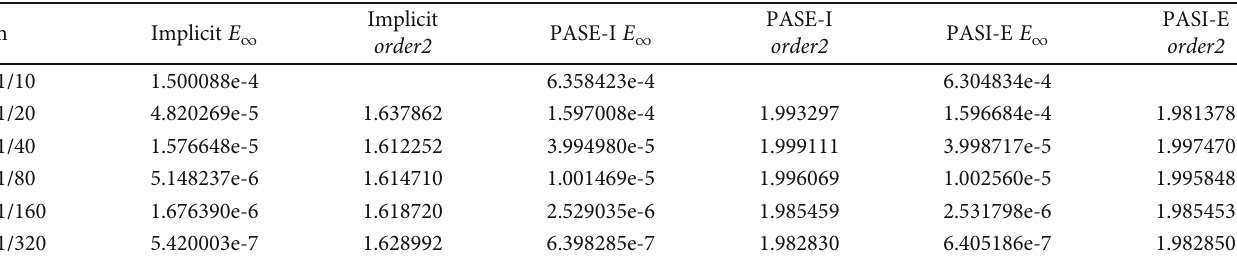
Table 2: Space order ( order2 ) of di ff erence